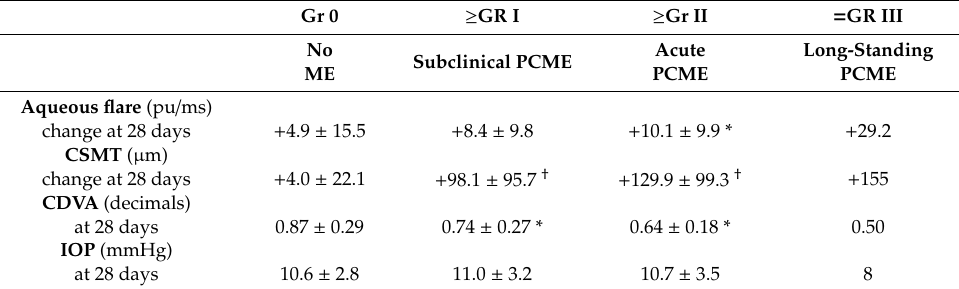
Table 3. Clinical outcomes according to the PCME